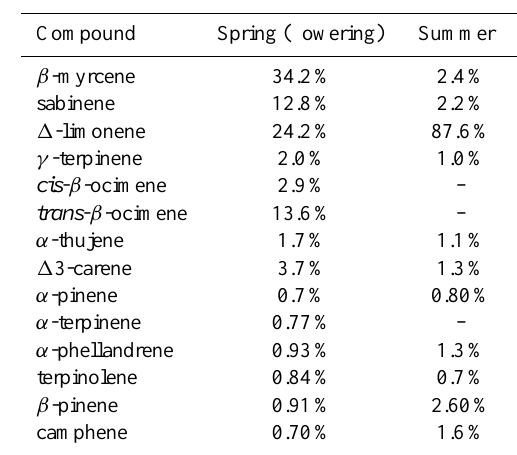
Table 7. Summary of monoterpene composition for both seasonal campaigns at